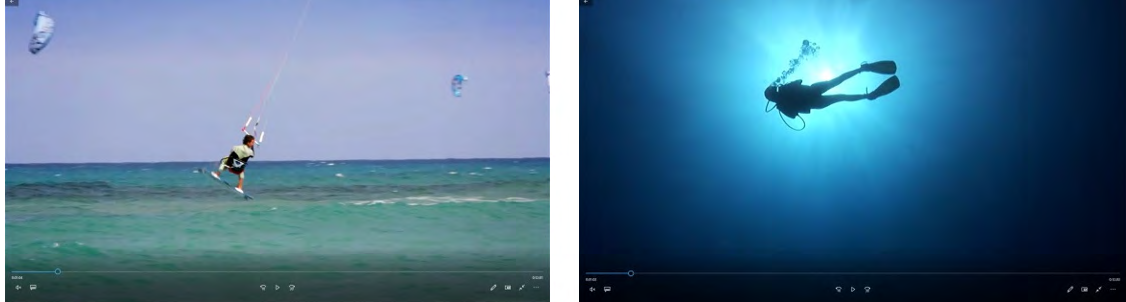
Figure 18. Used sports in the campaign (New Egypt Old Friends, 2016) Governance